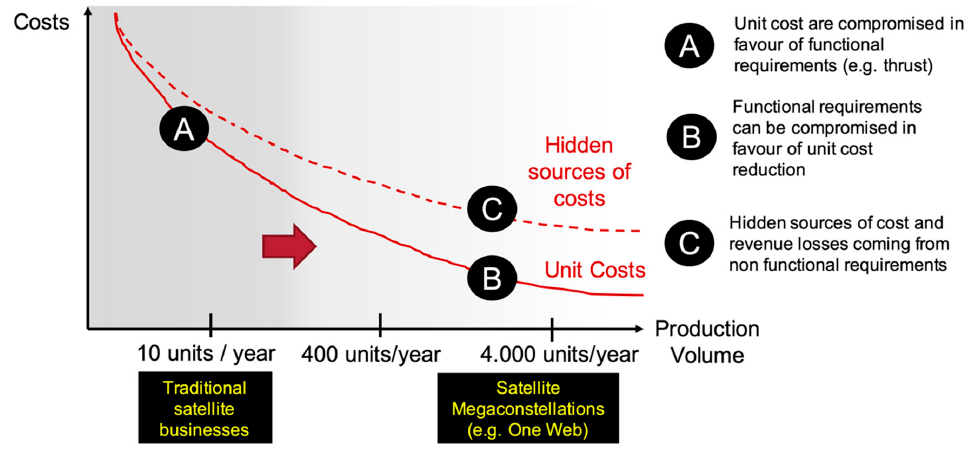
Figure 1. The increased production volumes expected for new space business scenarios is changing the way design trade-offs have to be considered.